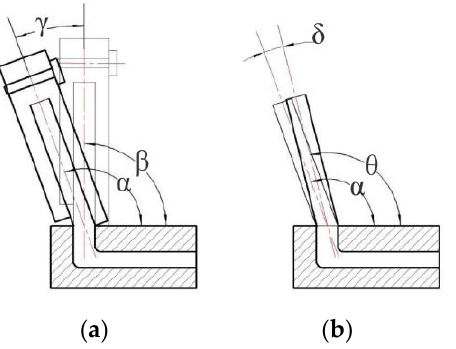
Figure 16. Schematic diagram of brush wire rebound: ( a ) Wire forming process, ( b ) wire rebound